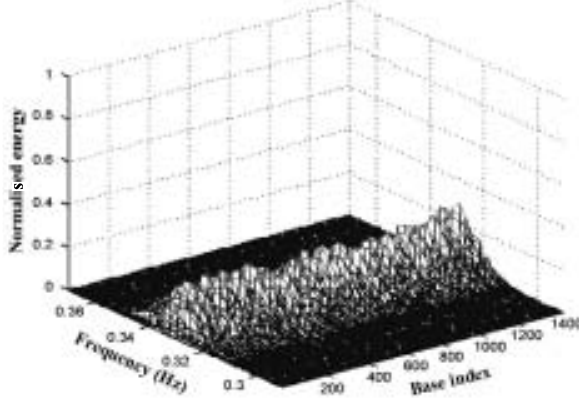
Figure 11 BWT analysis of the gene sequence with adaptive